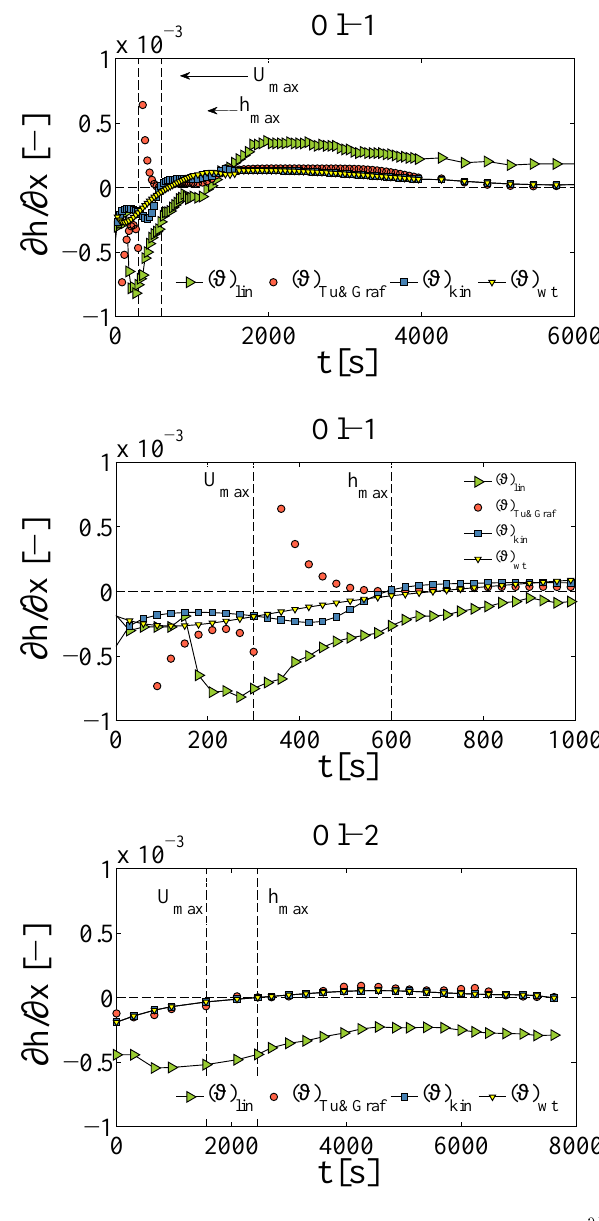
Figure 7. Temporal variability of gradient of flow depth ϑ = ∂h for experimental flood waves in the Olszanka watercourse. Middle panel shows an enlargement of the rising limb of the wave for Ol-1.